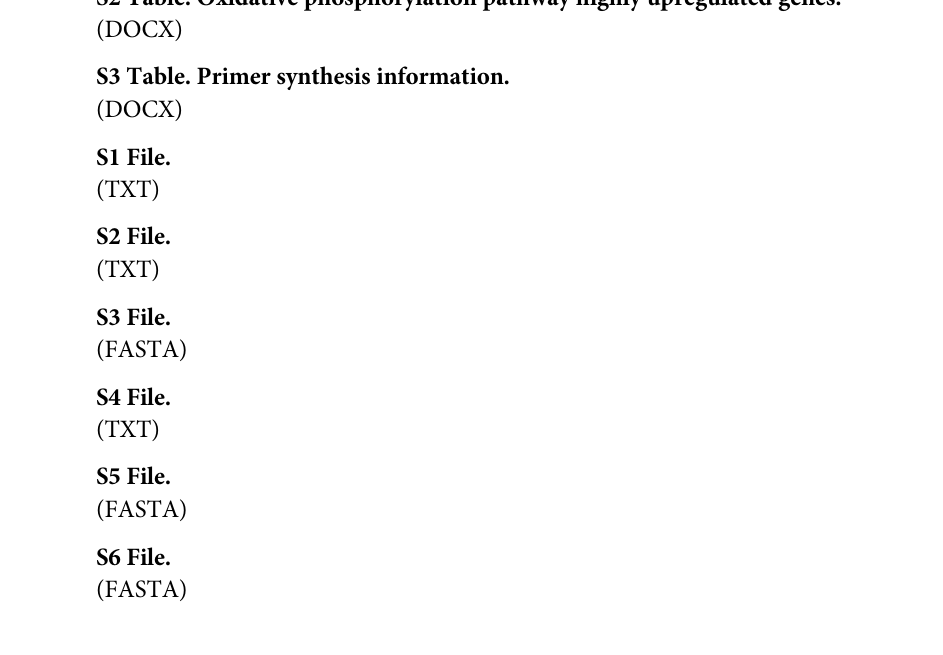
S1 Fig. A. PCA analysis diagram of maize leaf gene differences; B is the volcano map of gene expression. S2 Fig. GO Functional classification of differentially expressed genes in maize leaves. S3 Fig. The effect of stabilizing soil water content on the photosynthesis pathway of maize. S4 Fig. The effect of stabilizing soil water content on the oxidative phosphorylation path- way of maize. S5 Fig. RT-PCR validation of differential transcription identified by RNA-seq. S1 Table. Photosynthesis pathway highly upregulated genes. S2 Table. Oxidative phosphorylation pathway highly upregulated genes. S3 Table. Primer synthesis